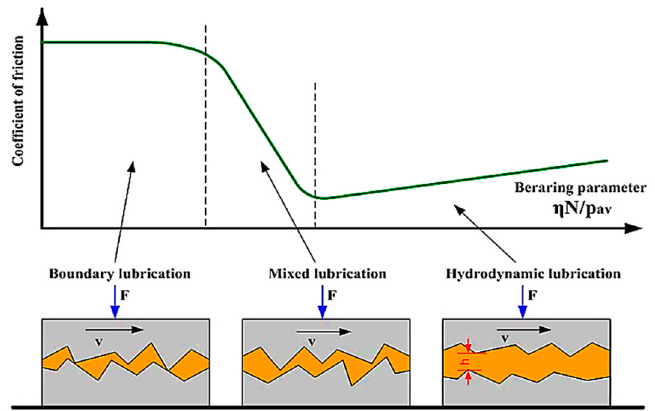
Figure 15. Lubrication regimes.